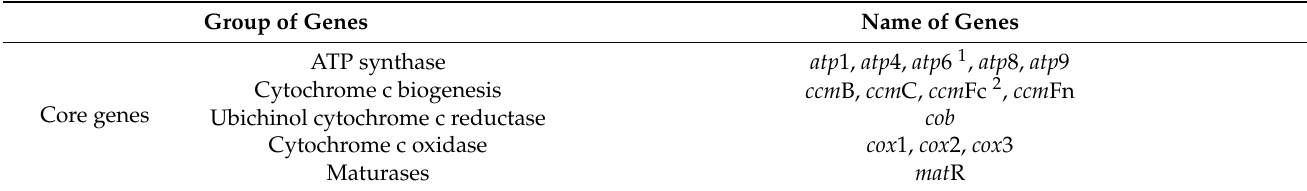
Figure 1. The circular map of P. salicina mitogenome. Genes belonging to different functional groups were color coded. ATP: adenosine-triphosphate; SSU: ribosomal small subunit; LSU: ribosomal large subunit; NADH: Nicotinamide adenine dinucleotide. Table 1. Gene composition in the mitogenome of P. salicina